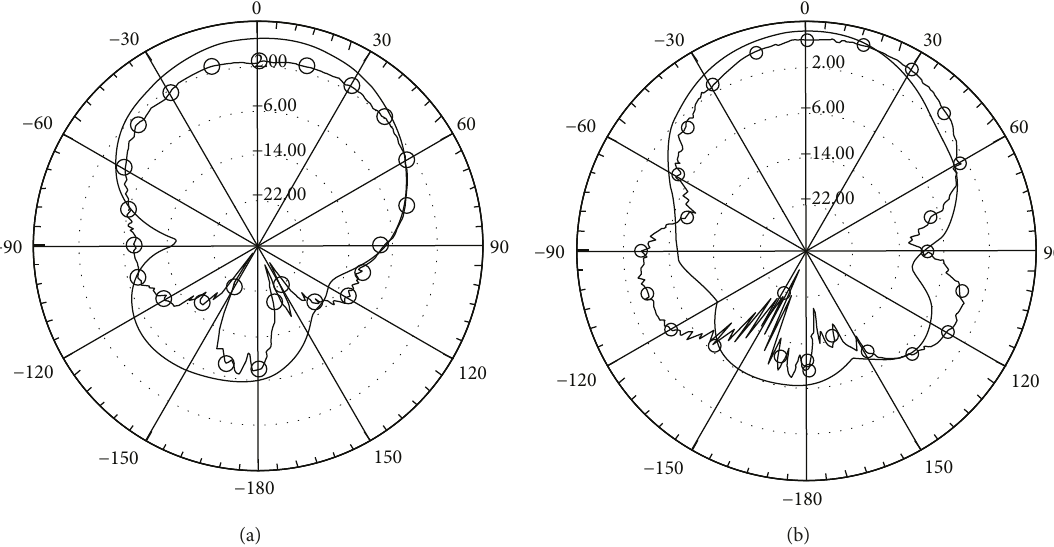
Figure 11: Measured and simulated 2-D radiation patterns of the proposed Yagi antenna at di ff erent frequencies (solid line: simulated data; line with circle symbol: measured data): (a) 15 GHz; (b) 18GHz. 4.504.59